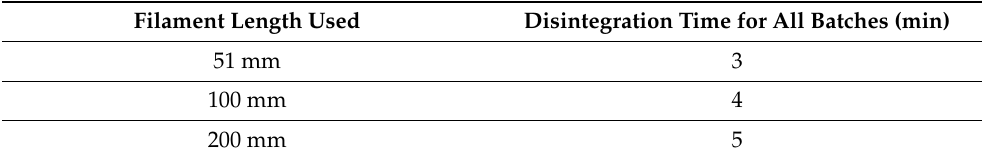
Table 13. Oral form disintegration times for three 3D-printed dosages.